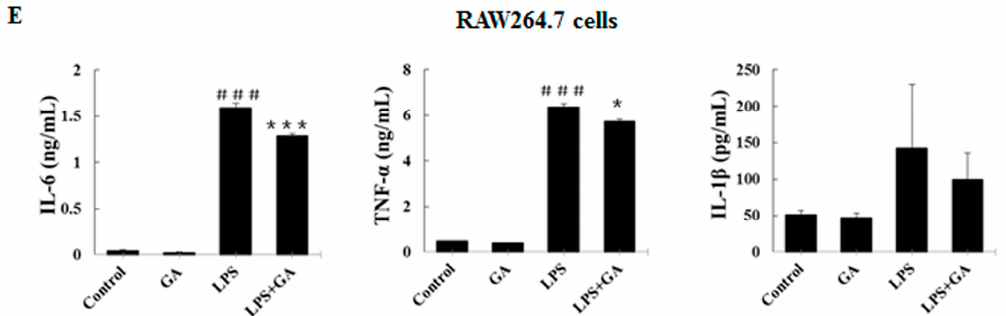
Figure 2. GA inhibits LPS-stimulate expression and production of pro-inflammatory cytokines in macrophages. ( A – C ) Effects of GA on LPS-stimulated mRNA expression of TNF- α , IL-6 , and IL-1 β . Following pre-treatment with GA for 1 h, mouse peritoneal macrophages ( A ), RAW264.7 cells ( B ),